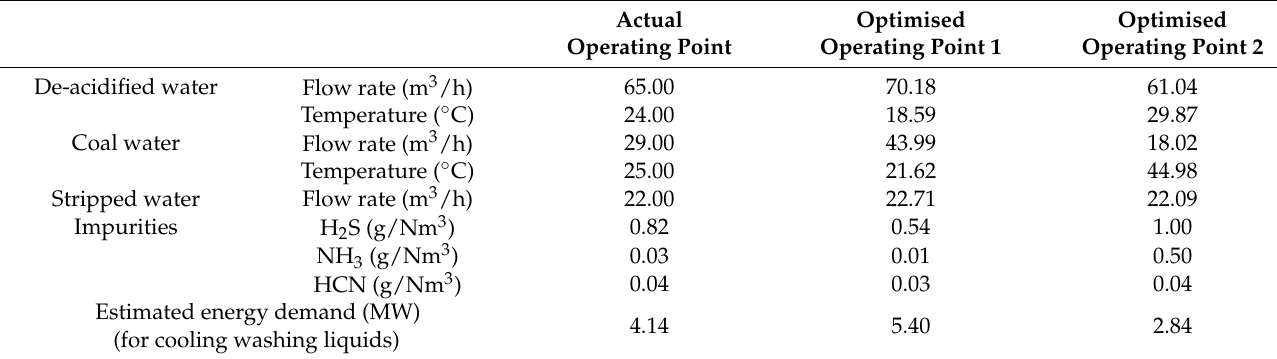
Table 6. Actual and optimised operation points.